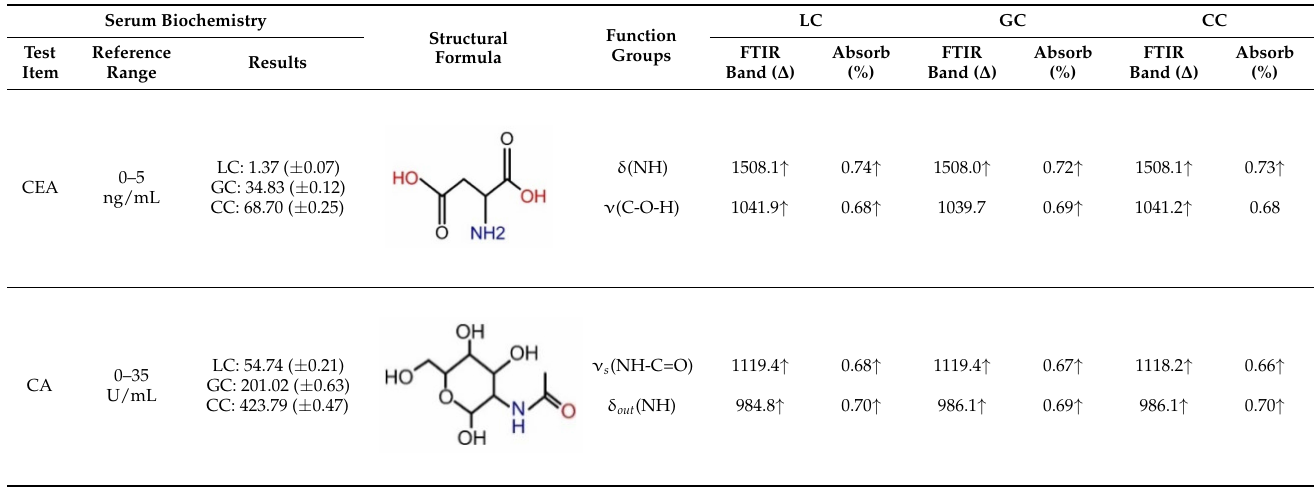
Table 2. Comparison and connection of clinic biochemistry and FTIR measurement for serum samples of